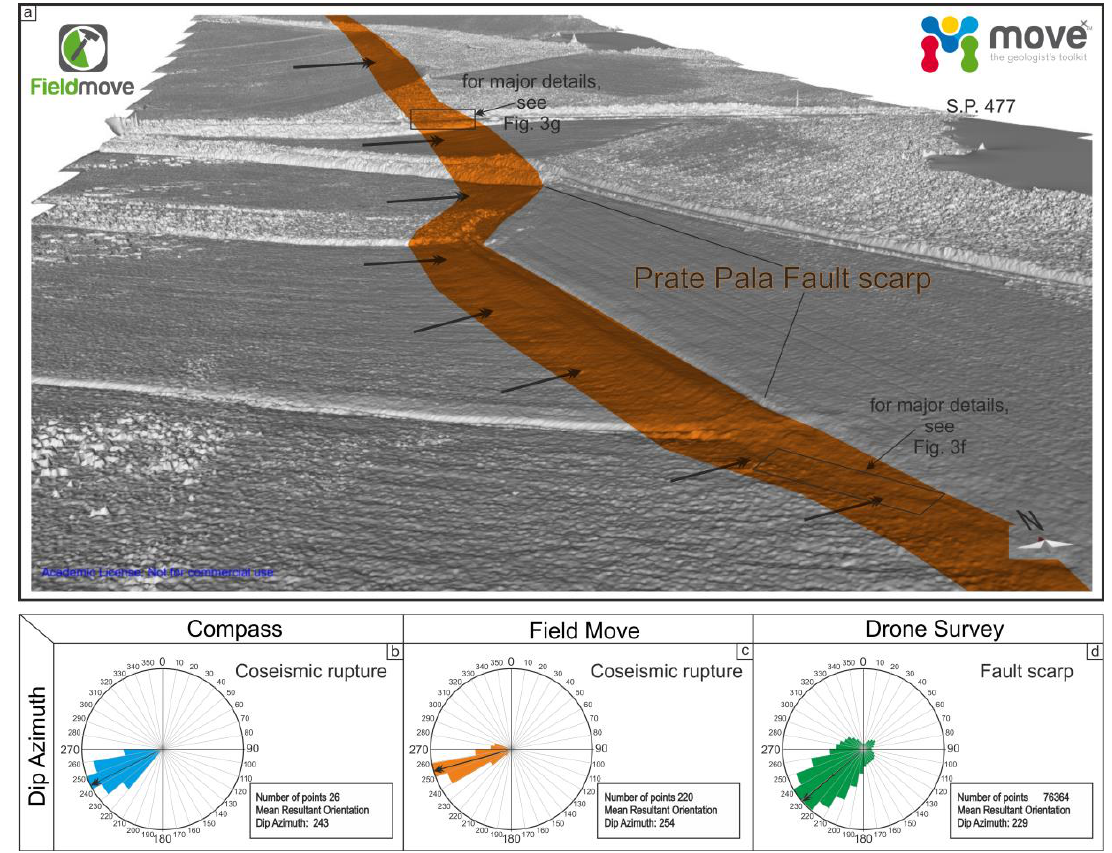
Figure 12. ( a ) Sample area 2: perspective 3D view extracted from Move Software of the PTP fault scarp in the Piano Grande near Castelluccio di Norcia; arrows show the alignment of the coseismic surface ruptures; in orange, the fault scarp of PTP is highlighted, black rectangles indicate the location of Figure 3f,g of coseismic ruptures measured during the field survey after 30 October 2016 Mw 6.5 earthquake ( b , c ) The plots show dip-azimuth of the coseismic ruptures measured with hand-compass and fieldmove; ( d ) trend of fault scarp obtained from a drone survey; for each rose diagram, the mean value resulting from the statistical analysis of the dataset is reported in the bottom-right rectangle Rose diagrams were extracted through Move 2019 software and redrawn through Corel Draw X4 software.